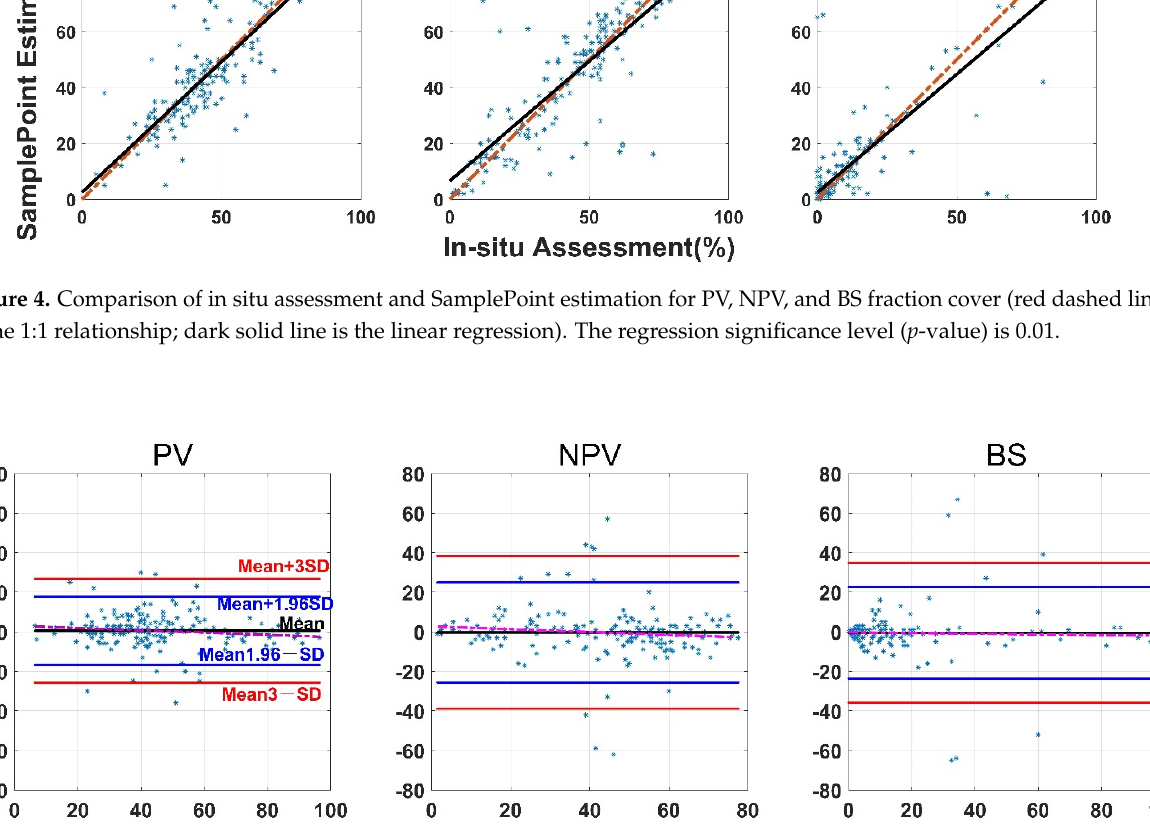
Figure 4. Comparison of in situ assessment and SamplePoint estimation for PV, NPV, and BS fraction cover (red dashed line is the 1:1 relationship; dark solid line is the linear regression). The regression significance level ( p -value) is 0.01.